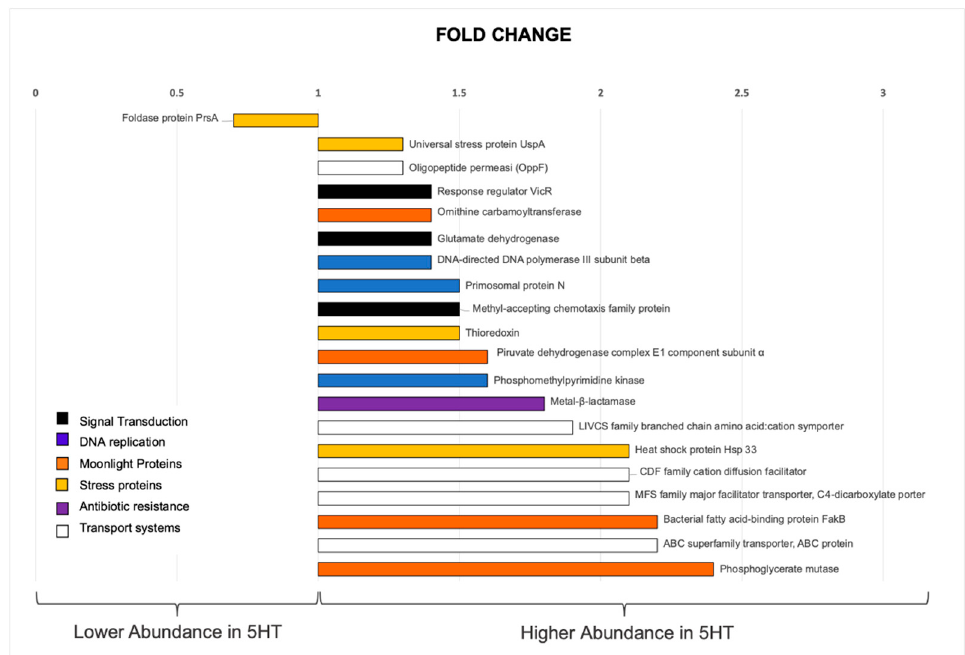
Figure 5. Proteomic relevant results . The bar chart shows the proteins with different abundance in 50 µM 5HT-treated E. faecium NCIMB 10415 compared to control condition ( p -value ≤ 0.05) and ordered by fold change. The proteins are divided in six main categories (signal transduction, DNA replication, moonlighting proteins, stress response proteins, proteins devoted to membrane transport, and to antibiotic resistance). On the left, the peptidyl-prolyl isomerase protein PrsA is displayed in lower abundance, while on the right, all the proteins with higher abundance in 5HT are presented. They are in order: Universal stress protein UspA, Oligopeptide permease (OppF), Response regulator VicR, Ornithine carbamoyltransferase, Glutamate dehydrogenase, DNA-directed DNA polymerase III subunit beta, Primosomal protein N, Methyl-accepting chemotaxis family protein, Thioredoxin, Piruvate dehydrogenase complex E1 component subunit α , Phosphomethylpyrimidine kinase, Metal- β -lactamase, LIVCS family branched chain amino acid: cation symporter, Heat shock protein Hsp 33, CDF family cation diffusion facilitator, MFS family major facilitator transporter, C4-dicarboxylate porter, FakB bacterial fatty acid-binding protein, and an ABC superfamily